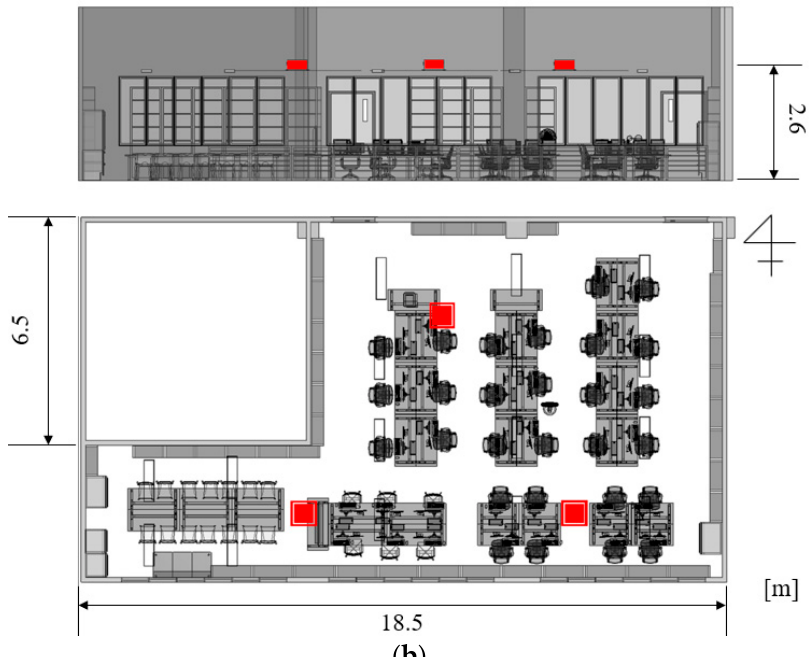
Figure 9. Room 411 BIM model: ( a ) 3D view; ( b ) 2D View.